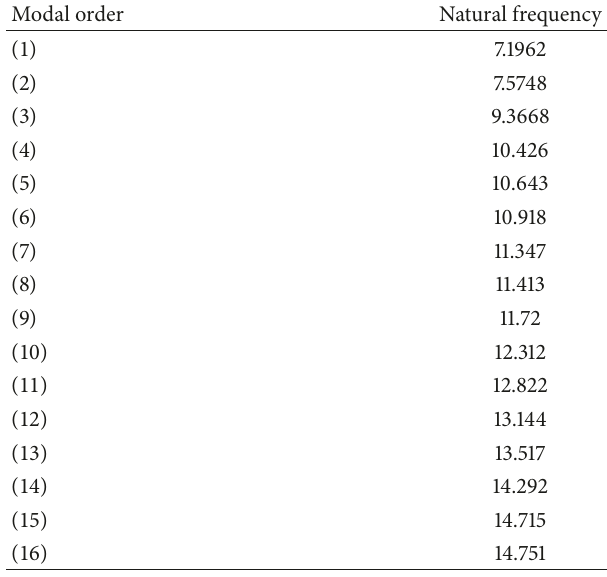
Table 3: Natural frequencies of the system (1st approach).